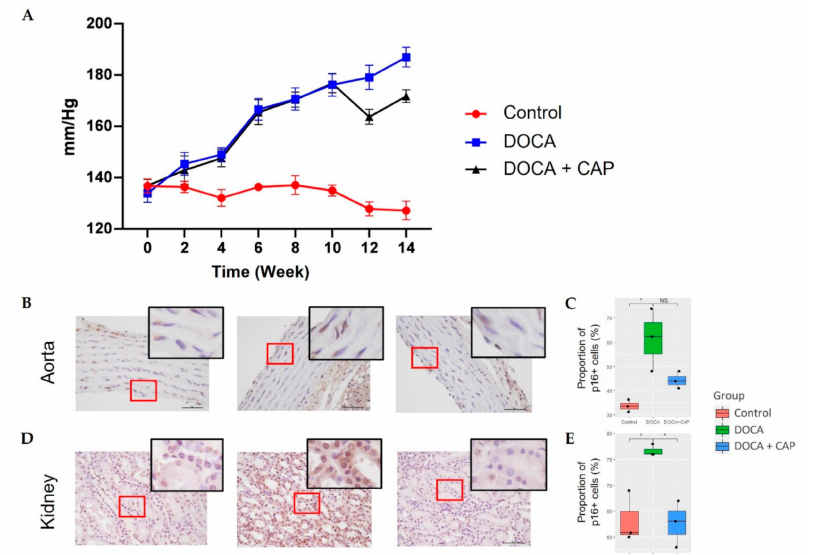
Figure 1. ( A ) Blood pressure measured every 2 weeks from week 0 to week 14 of the Control, DOCA, and DOCA + Captopril groups. The treatment of DOCA starts from w0. In week 9, DOCA + Captopril groups began to feed captopril ( n = 8 for each group). The results of p16 staining in the aorta ( B ) and kidney ( D ) with red boxes highlighting the p16-positive cells. ( C , E ) show the percentage of p16-positive cells in the aorta and kidney, respectively. (* p <